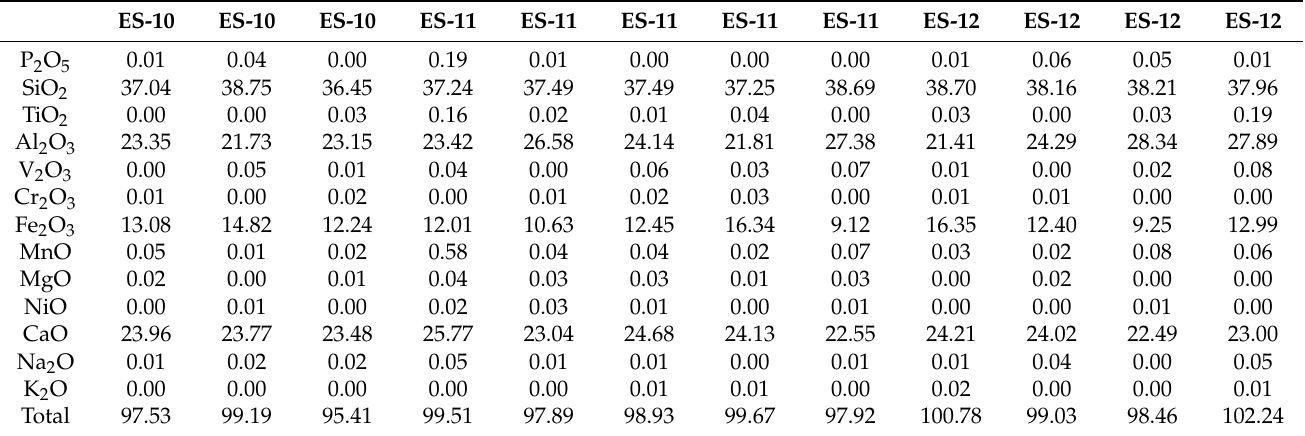
Table 3. Electron microprobe analyses (in wt.% of oxides) of the epidote breakdown products (bulk from area with 5 µ m diameter).